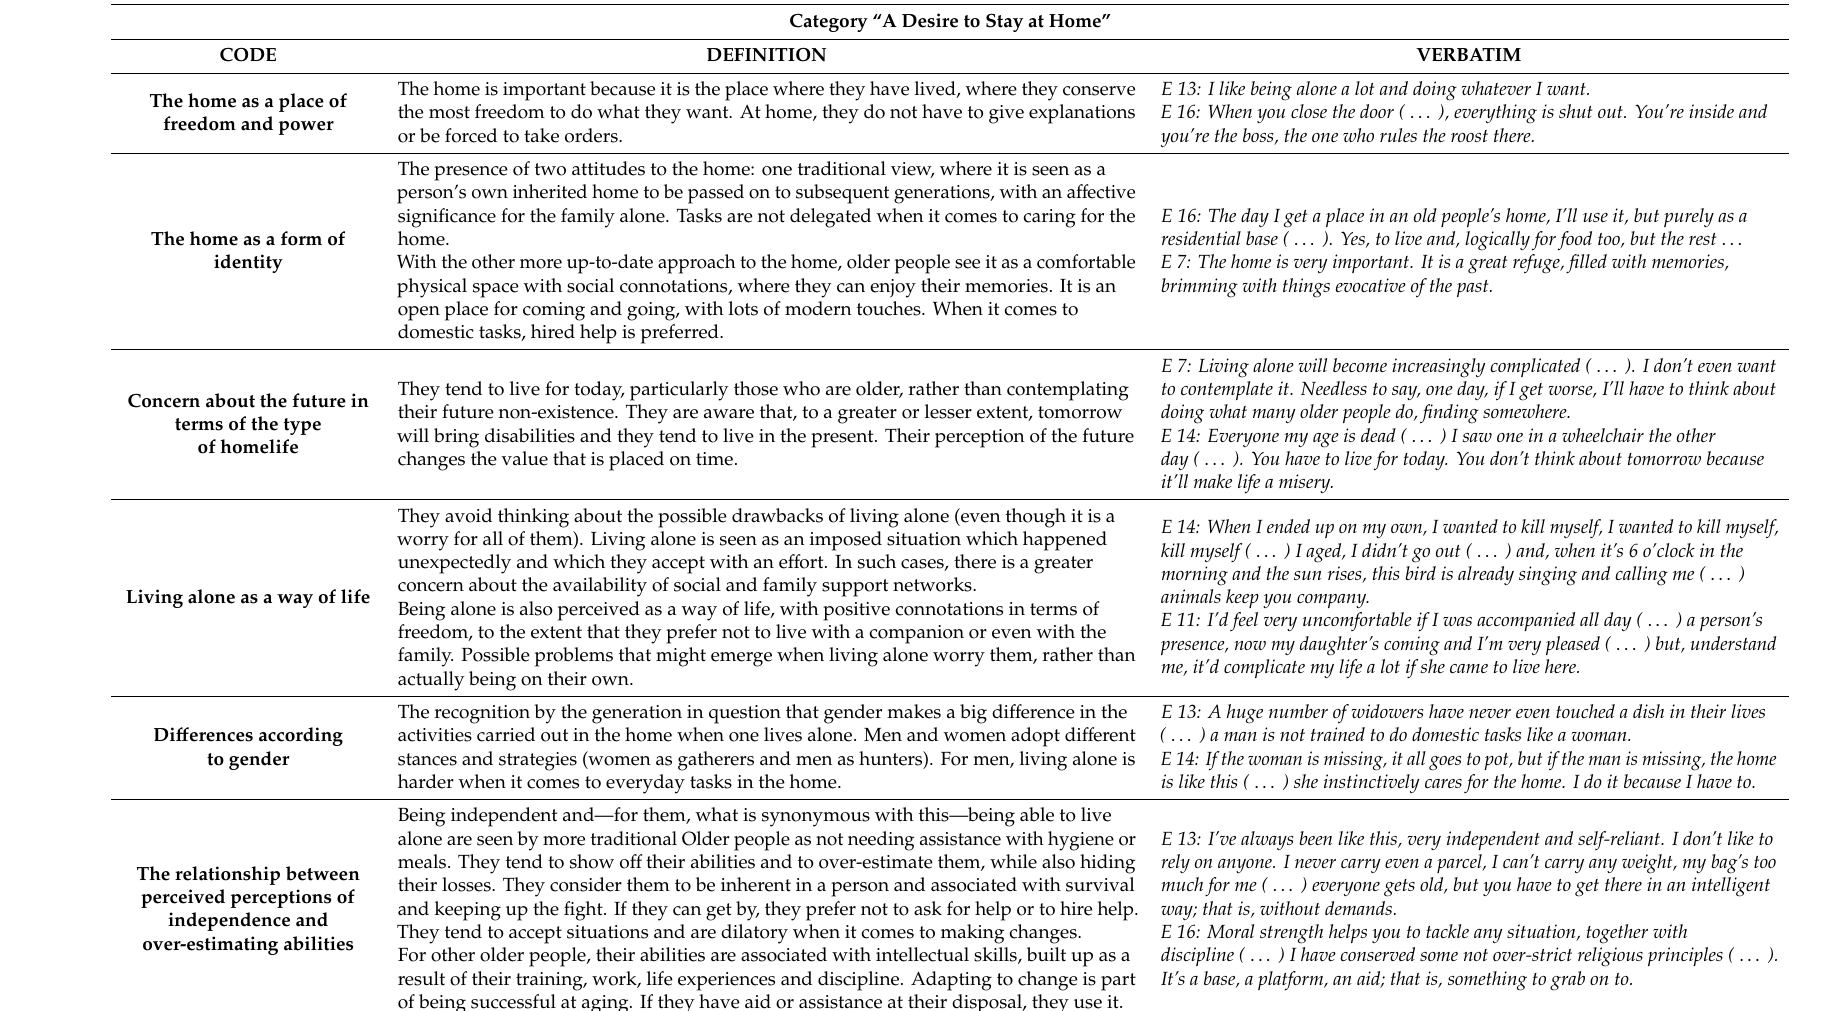
Table 1. Categories and codes from interviews with over 70 year olds living